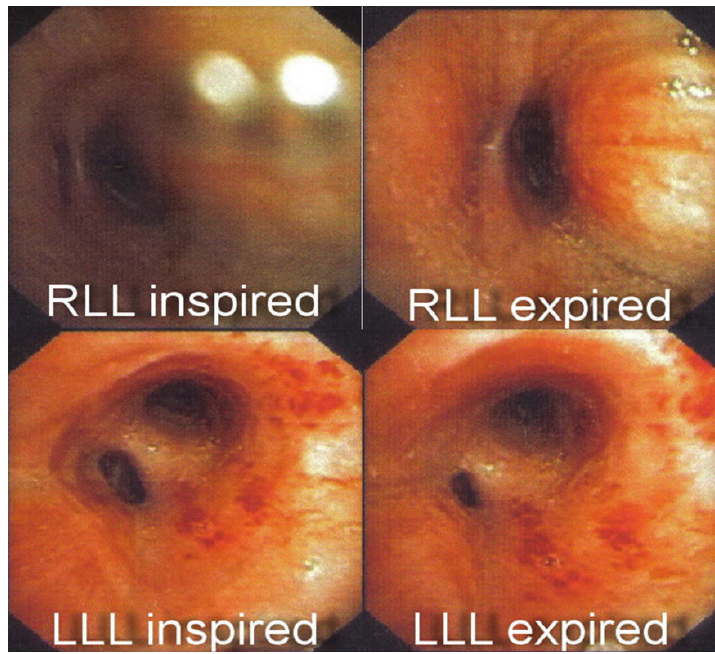
Figure 2: Bronchoscopy images during inspiration and